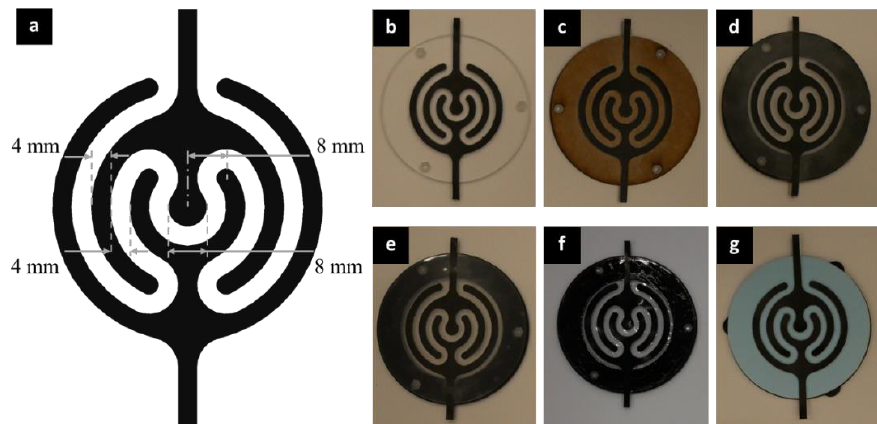
Figure 2. ( a ) The EA electrodes follow a concentric-comb pattern. It has an e ff ective diameter of 56 mm with an electrode width and gap of 4 mm. ( b – g ) fabricated EA grippers with di ff erent base materials: ( b ) acrylic; ( c ) medium-density fibreboard (MDF); ( d ) silicone film; ( e ) polyacrylate elastomer (VHB) film; ( f ) Mylar plastic film; and ( g ) Styrofoam.